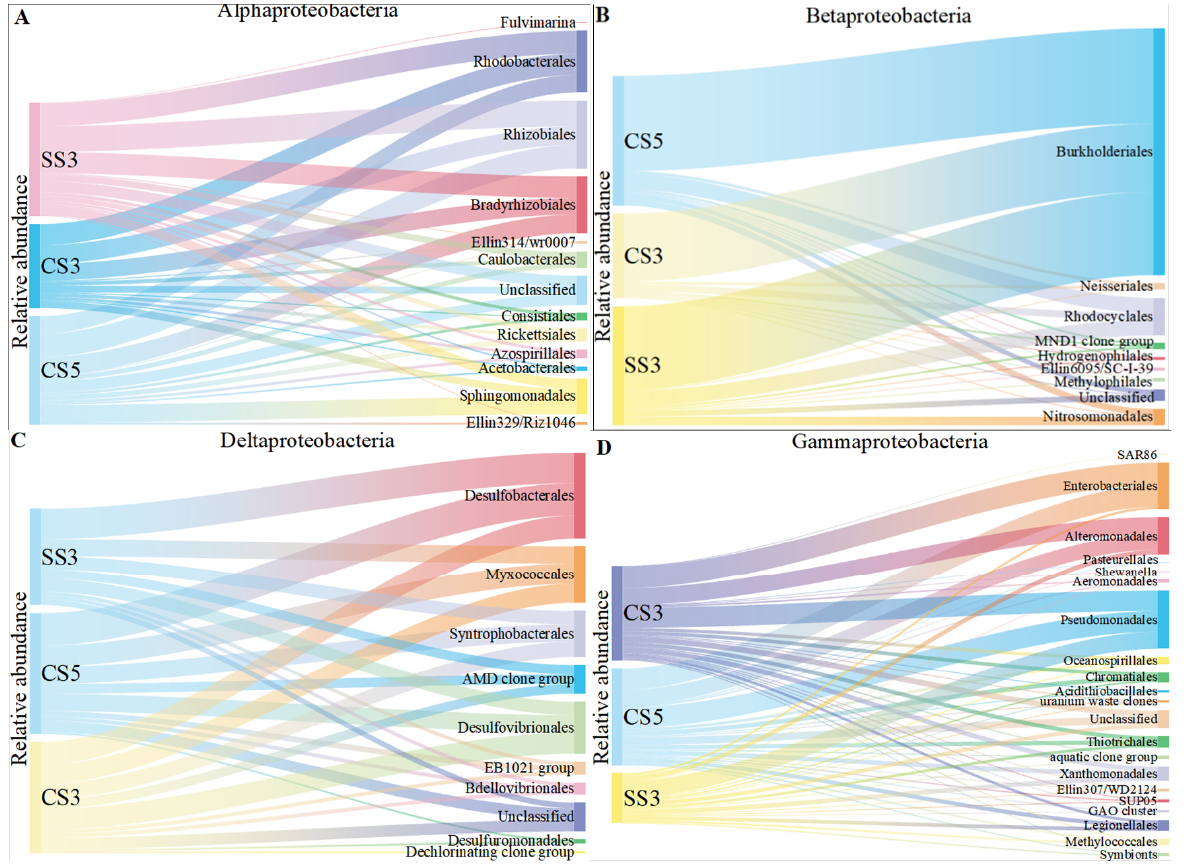
Figure 4. The taxonomic distribution of the α -Proteobacterial ( A ), β -Proteobacterial ( B ), δ -Proteobacterial ( C ) and γ -Proteobacterial ( D ) orders on the microarray.